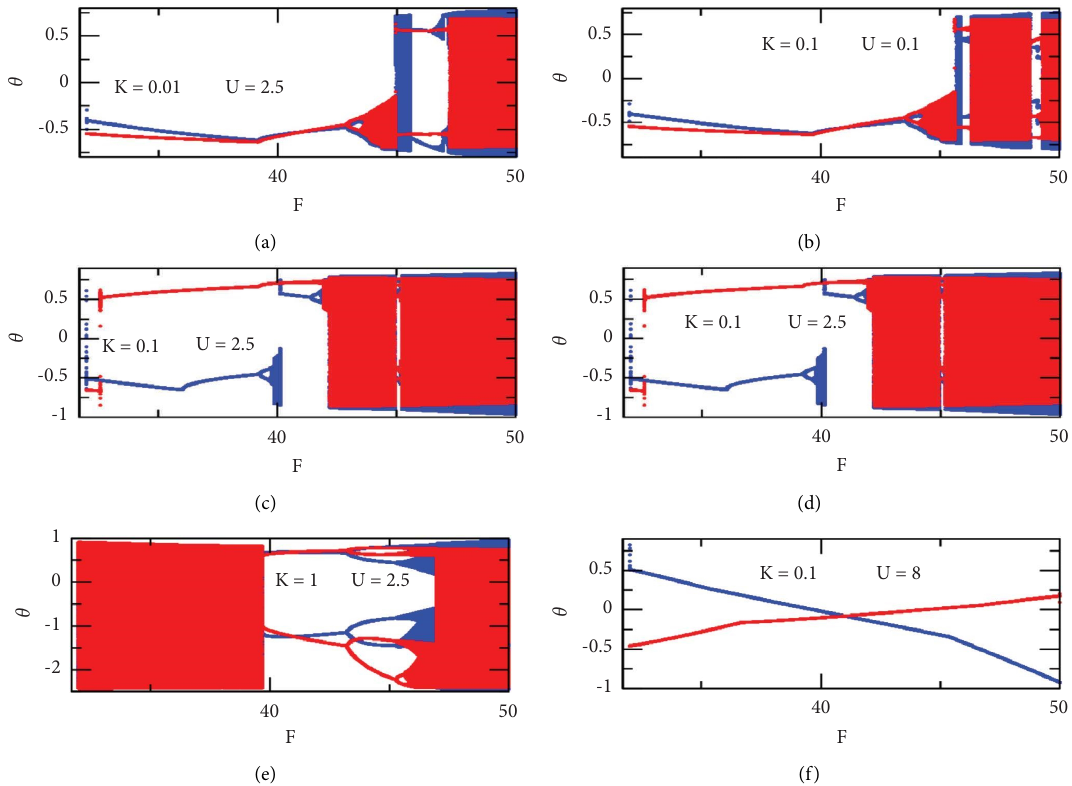
Figure 12: Effect of the parameters K and U on the bifurcation diagram for ϵ � 1 ; α � 10 ; β � 1 ; Ω � 2 ; C )e diagrams are drawn by sweeping the normalized amplitude F in the ascending direction (blue) and in the opposite direction